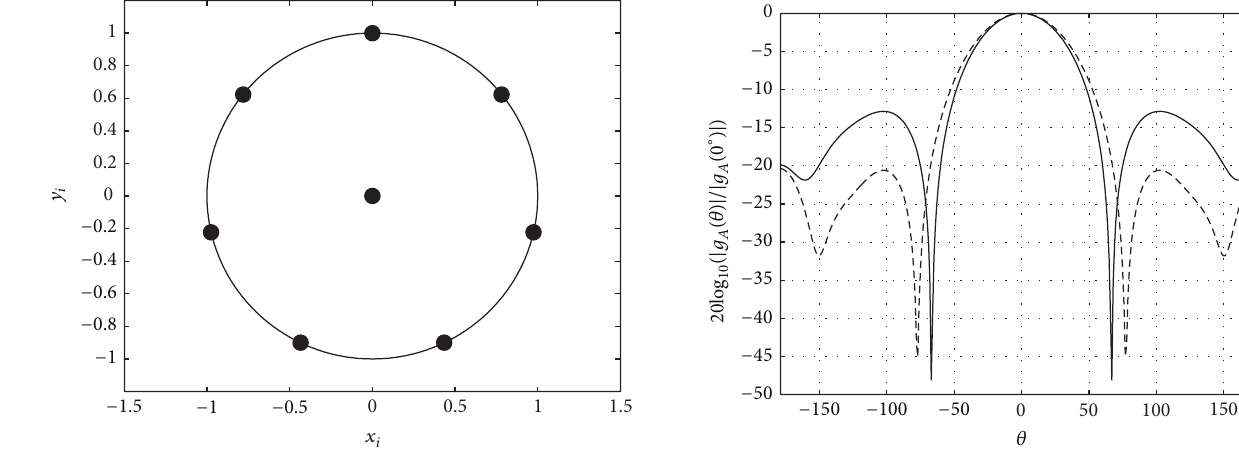
Figure 2: Circular configuration with central element for 𝑁 = 8 .